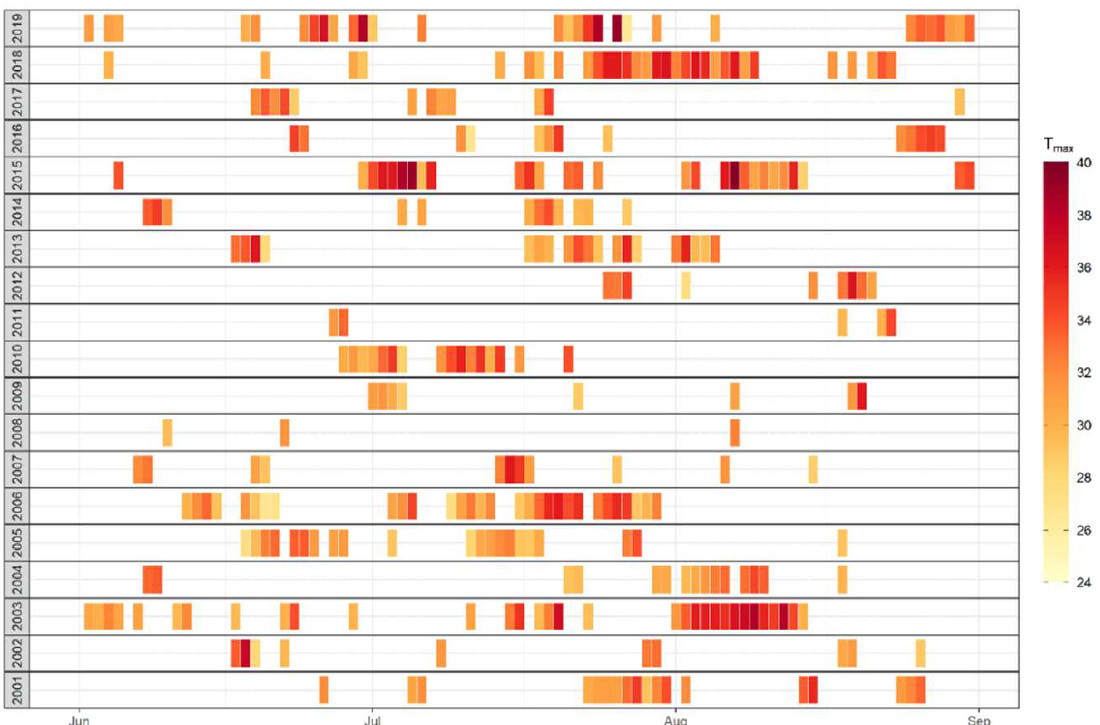
Figure 1. Daily air temperature maximum (Tmax in °C) on days during summer months exceeding the 95th percentile of the daily average air temperature calculated for the period 2001 to 2019 at the DWD station Frankfurt/Main-Westend.